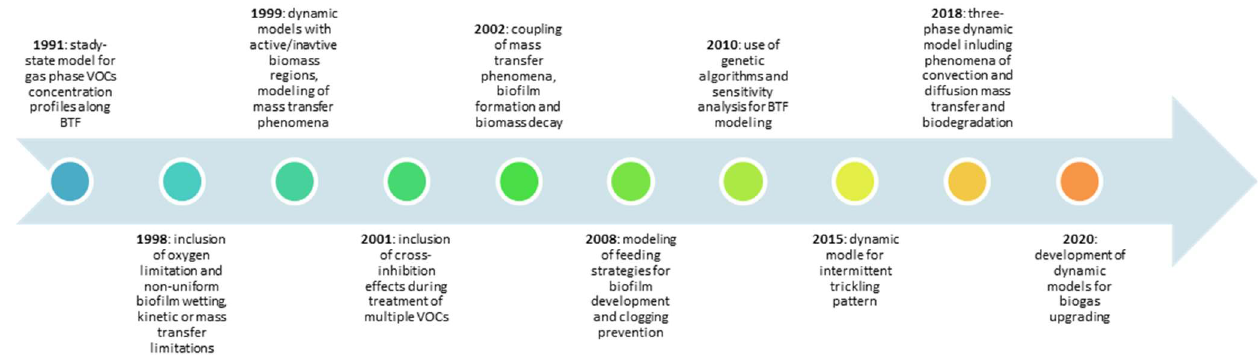
Figure 1. Milestones in the development of mathematical models for biotrickling filtration of air polluted with VOCs.